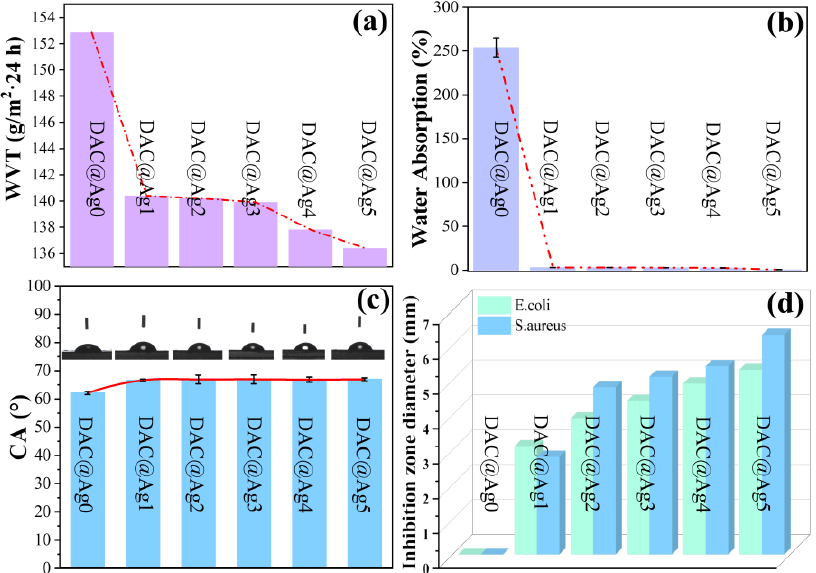
Figure 8. Water vapor transmission rate (WRT) ( a ), water absorption ( b ), water contact angle ( c ), and bacterial inhibition zone ( d ) of DAC@Ag0-DAC@Ag5 films.